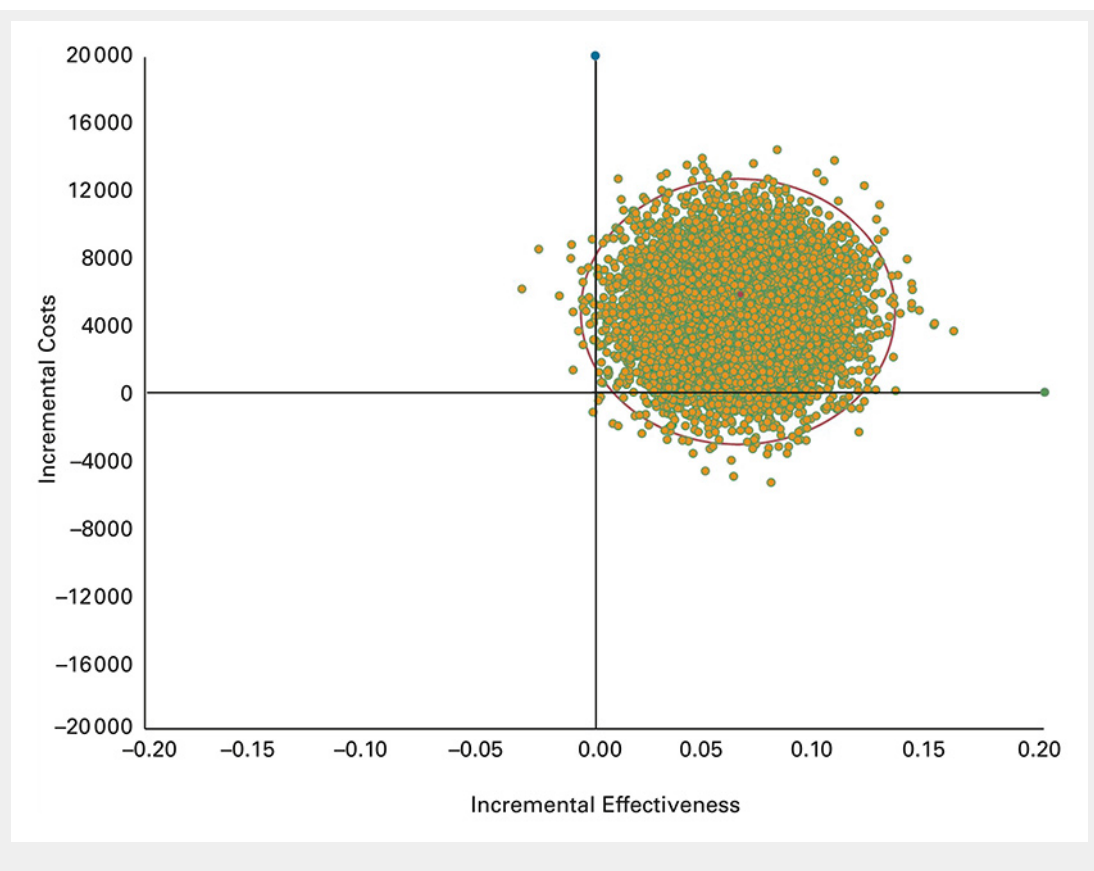
Figure 3 Scatter plot of incremental costs per person and incremental effectiveness derived from 10 000 iterations of the Monte Carlo simulation. Incremental effectiveness is expressed as quality adjusted life years (QALYs) gained and incremental costs are in CHF, from the societal